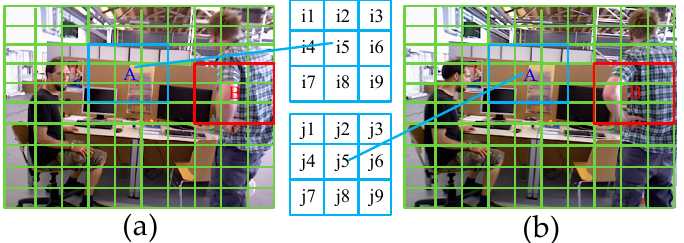
Figure 4. ( a ) Grid division of the first frame image. ( b ) Grid division of the Nth (the sliding window size) frame image. Where A and B represent the center area of a 3 × 3 grid corresponding to the left and right image.